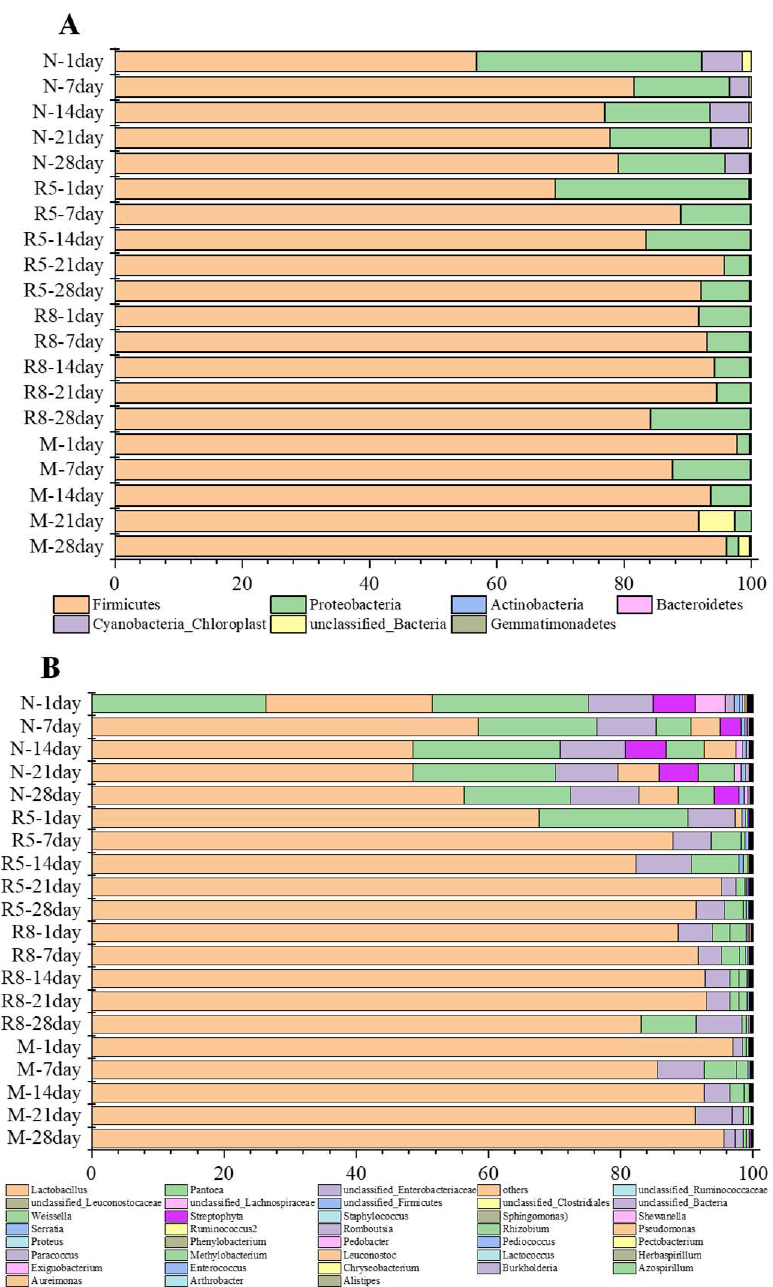
Figure 7. The distribution of bacteria in pickles at the phylum ( A ) and genus ( B ) levels. The relative abundance was estimated from 16S rRNA gene sequences.